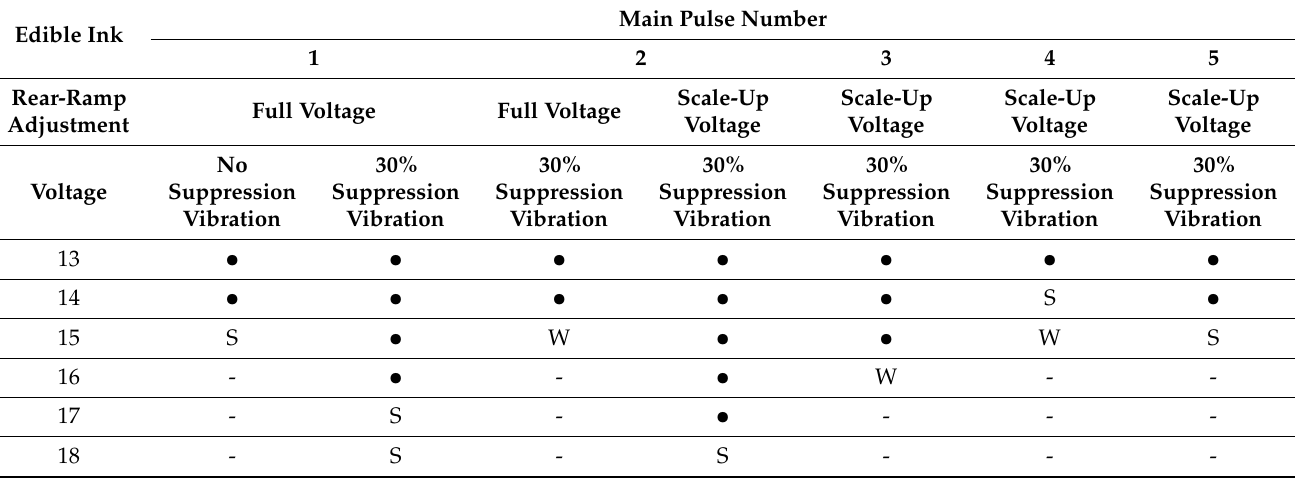
Table 2. Experimental results with different input parameters (modified W waveform with and without 30% suppression vibration).